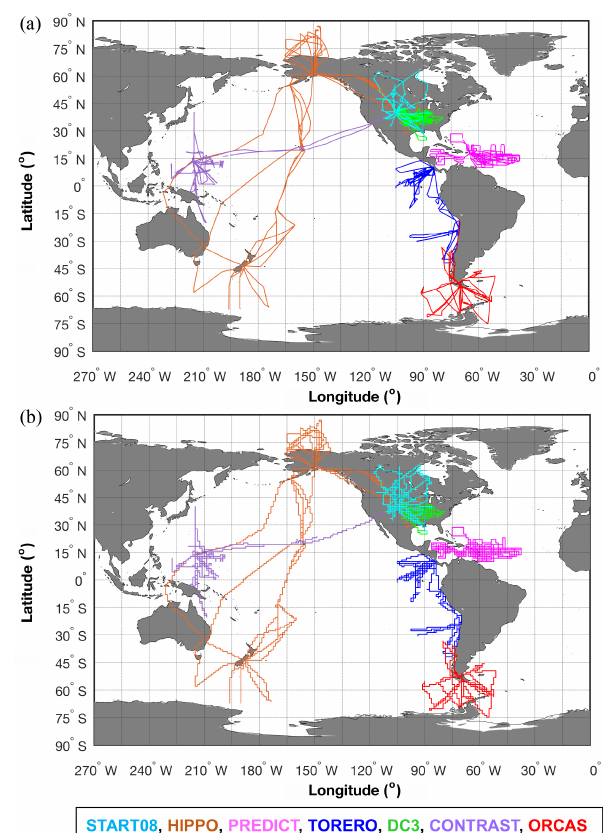
Figure 1. Global maps of flight tracks representing the seven cam- paigns in this study for (a) in situ observations and (b) CAM6-nudg. Colors denote different